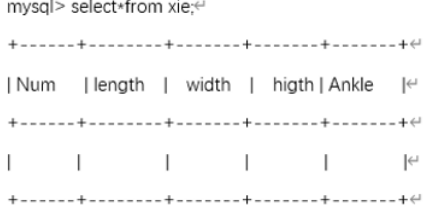
Fig. 3. Data base. Fig. 4. Shoe last data